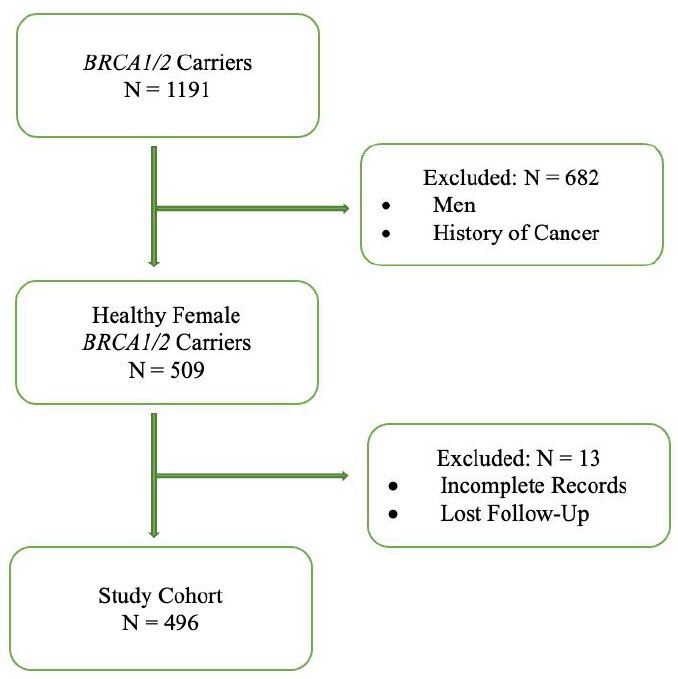
Figure 1. Flow-Chart: Selection of Study